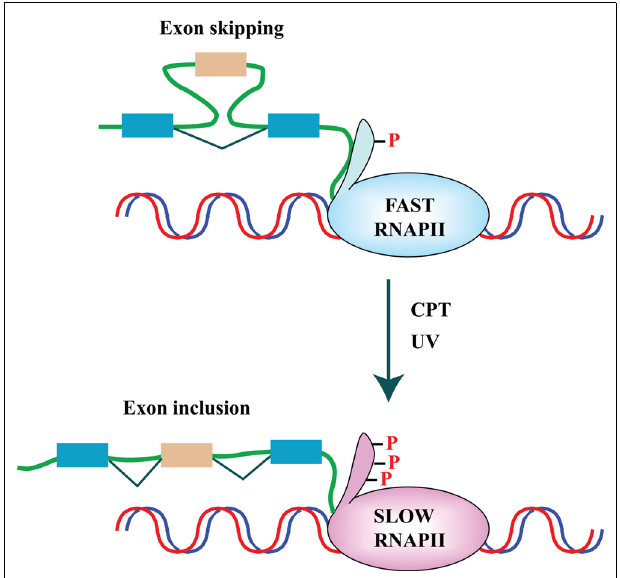
FIGURE 2 | DNA damage affects splicing decisions by modulating the phosphorylation status of RNAPII and the elongation rate of transcription. CPT-inducedTop1ccs have immediate and specific effects on RNAPII. CPT triggers a high degree of phosphorylation of the largest subunit (Rpb1) of RNAPII (Baranello etal., 2010). Ultraviolet (UV) irradiation affects cotranscriptional alternative splicing in a p53-independent